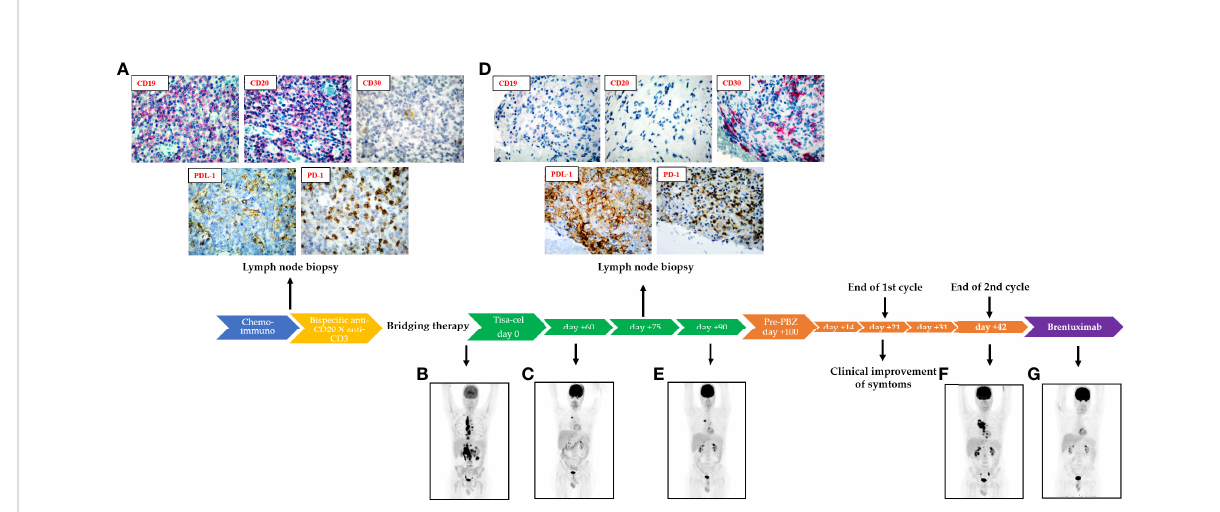
FIGURE 1 Clinical course. (A) Clinical timeline with immunohistochemical evaluation of lymph node biopsy at pre-bispeci fi c (anti-CD20Xanti-CD3) antibody stage, that shows CD19 and CD20 positivity, CD30 negativity, the expression of PD-L1 in the neoplastic population and PD-1 in the tumor microenvironment. Relevant PET/TC scans at: (B) pre-CAR-T cell therapy, (C) day +60 after CAR-T cell infusion. (D) Immunohistochemical evaluation of lymph node biopsy at: pre-PBZ administration stage, that shows CD19 and CD20 negativity, CD30 positivity, the expression of PD-L1 in the neoplastic population and PD-1 in the tumor microenvironment. Relevant PET/TC scans: (E) at day +90 after CAR-T cell therapy, (F) at day +42 following PBZ treatment, (G) after the 4 th cycle of